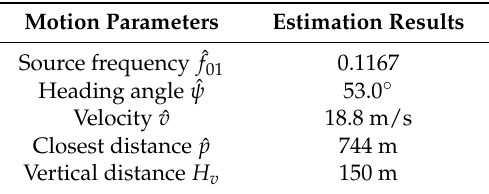
Table 7. The parameter estimation results.